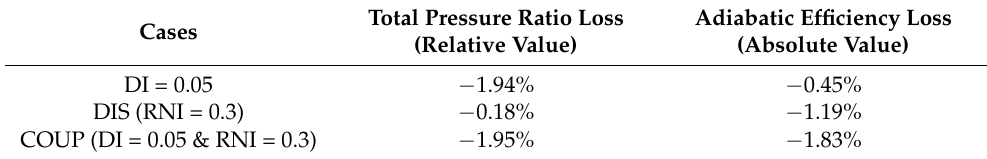
Table 2. Comparison of performance losses under different working conditions (at PE point).